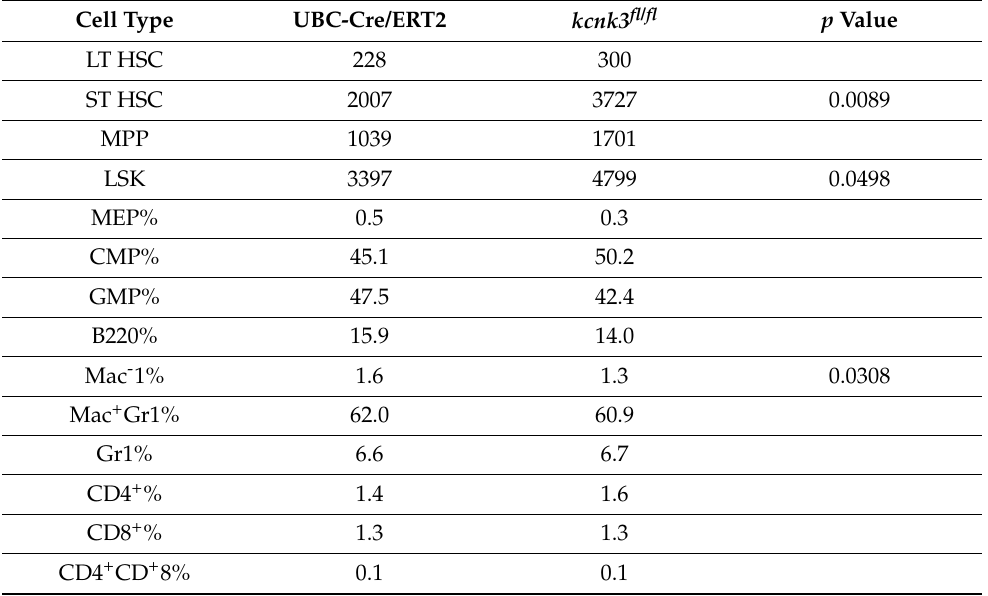
Table 2. Assessment of bone-marrow derived myeloid, lymphoid and hematopoietic stem and progenitor cells by flow cytometry. Cell numbers are expressed as total number per million bone marrow cells. LT-HSC, long-term hematopoietic stem cells; ST-HSC, short-term hematopoietic stem cells; MPP, multipotent progenitors; LSK, enrichment of stem cells including LT-HSC, ST-HSC and MPP; MEP, megakaryocyte erythroid progenitor cells; CMP, hematopoietic stem cells + CD34 + Fc γ R − ; GMP, hematopoietic stem cells + CD34 + Fc γ R + ; B220, CD45R + B cells; Mac − 1, CD11b + macrophages; Mac + Gr1,